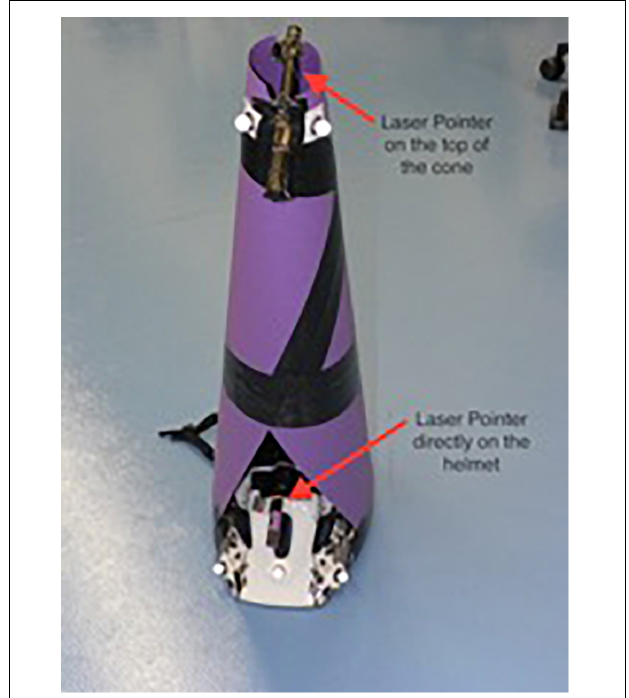
FIGURE 1 | Laser-cone used in Experiment